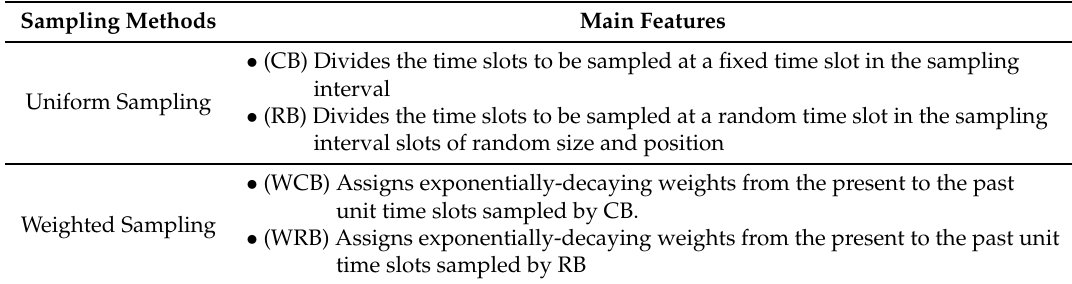
Table 2. Main features of uniform sampling and weighted sampling